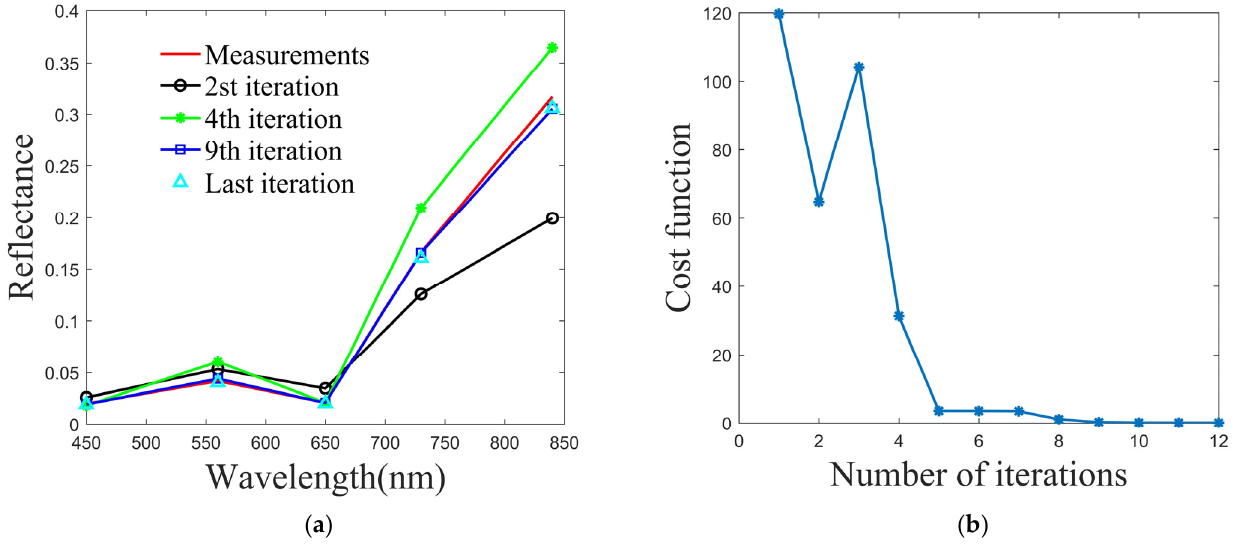
Figure 8. Retrieval process demonstration: ( a ) the illustration of the iterative process for reflectance based on the coupling model and ( b ) the description of the convergence process for the cost function.